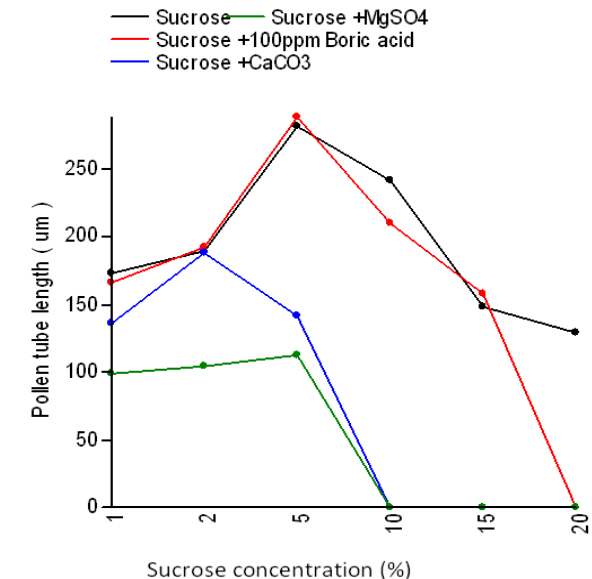
Fig. 2. Graph showing effect of media on pollen tube length af- ter anthesis on different concentration of media and sucrose solution in 4